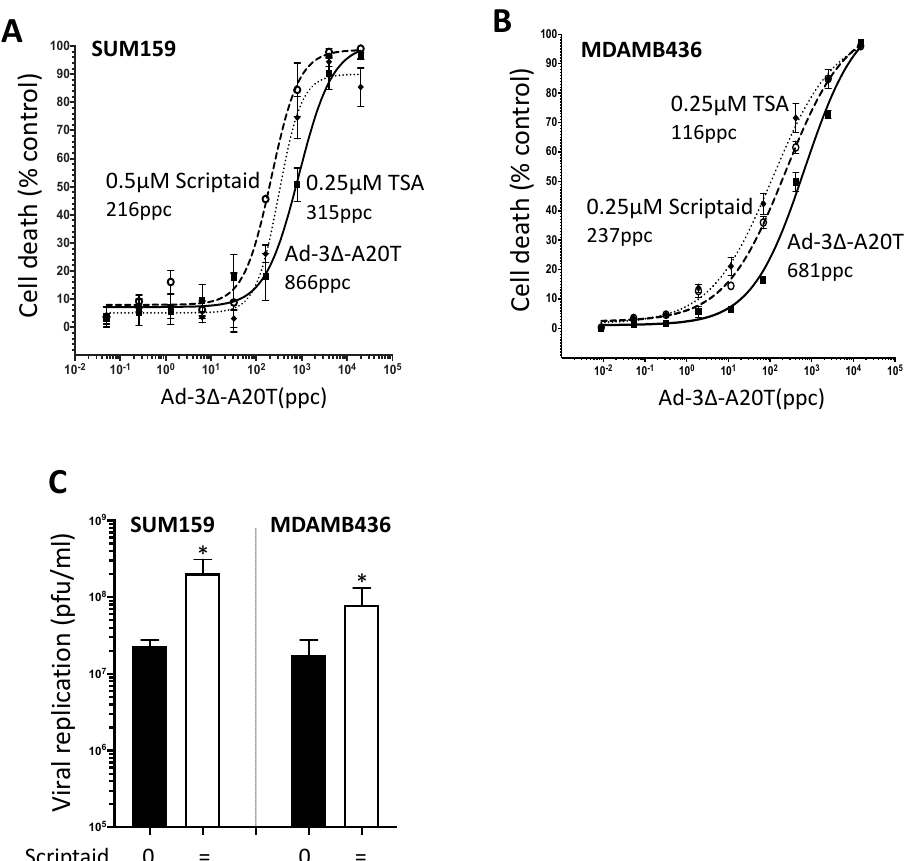
Figure 5. Addition of Scriptaid or TSA supports viral replication and sensitisation to the Ad-3 ∆ -A20T mutant in TNBC cells. SUM159 ( A ) and MDA-MB-436 ( B ) cells were infected with Ad-3 ∆ -A20T at increasing concentrations and treated with Scriptaid at 0.5 µ M (SUM159) or 0.25 µ M (MDA-MB436) or 0.25 µ M TSA added simultaneously. Cell viability was determined by MTS assay 3 d post-infection and EC 50 values calculated, one representative study out of three, in triplicate. ( C ) SUM159 and MDA-MB436 cells were infected with Ad-3 ∆ -A20T and treated with 0.1 µ M Scriptaid simultaneously. Cells and medium were harvested 48 h post-infection and assayed by TCID50 for replication. Data are expressed as averages ± SD ( n = 2, in duplicates), * p <